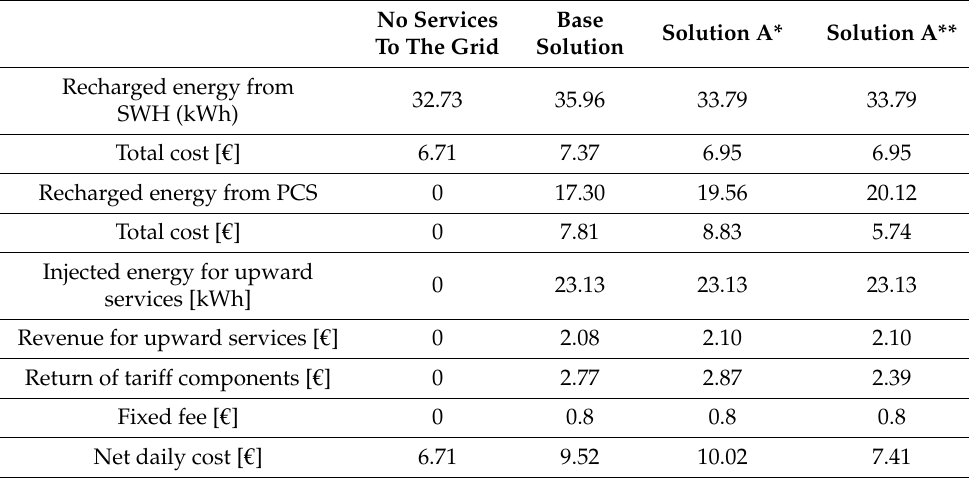
Table 25. Results for mobility pattern 2—UVAMbis (Scenario B).